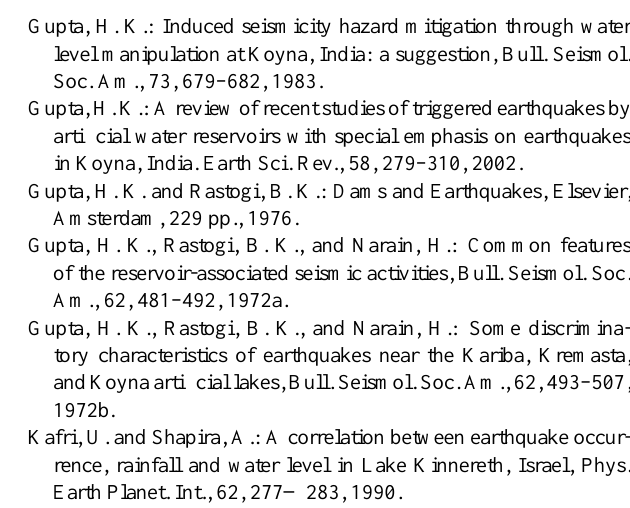
Table 2 The correlation coefficient, time lag and hydraulic diffusivity in different time intervals (years).